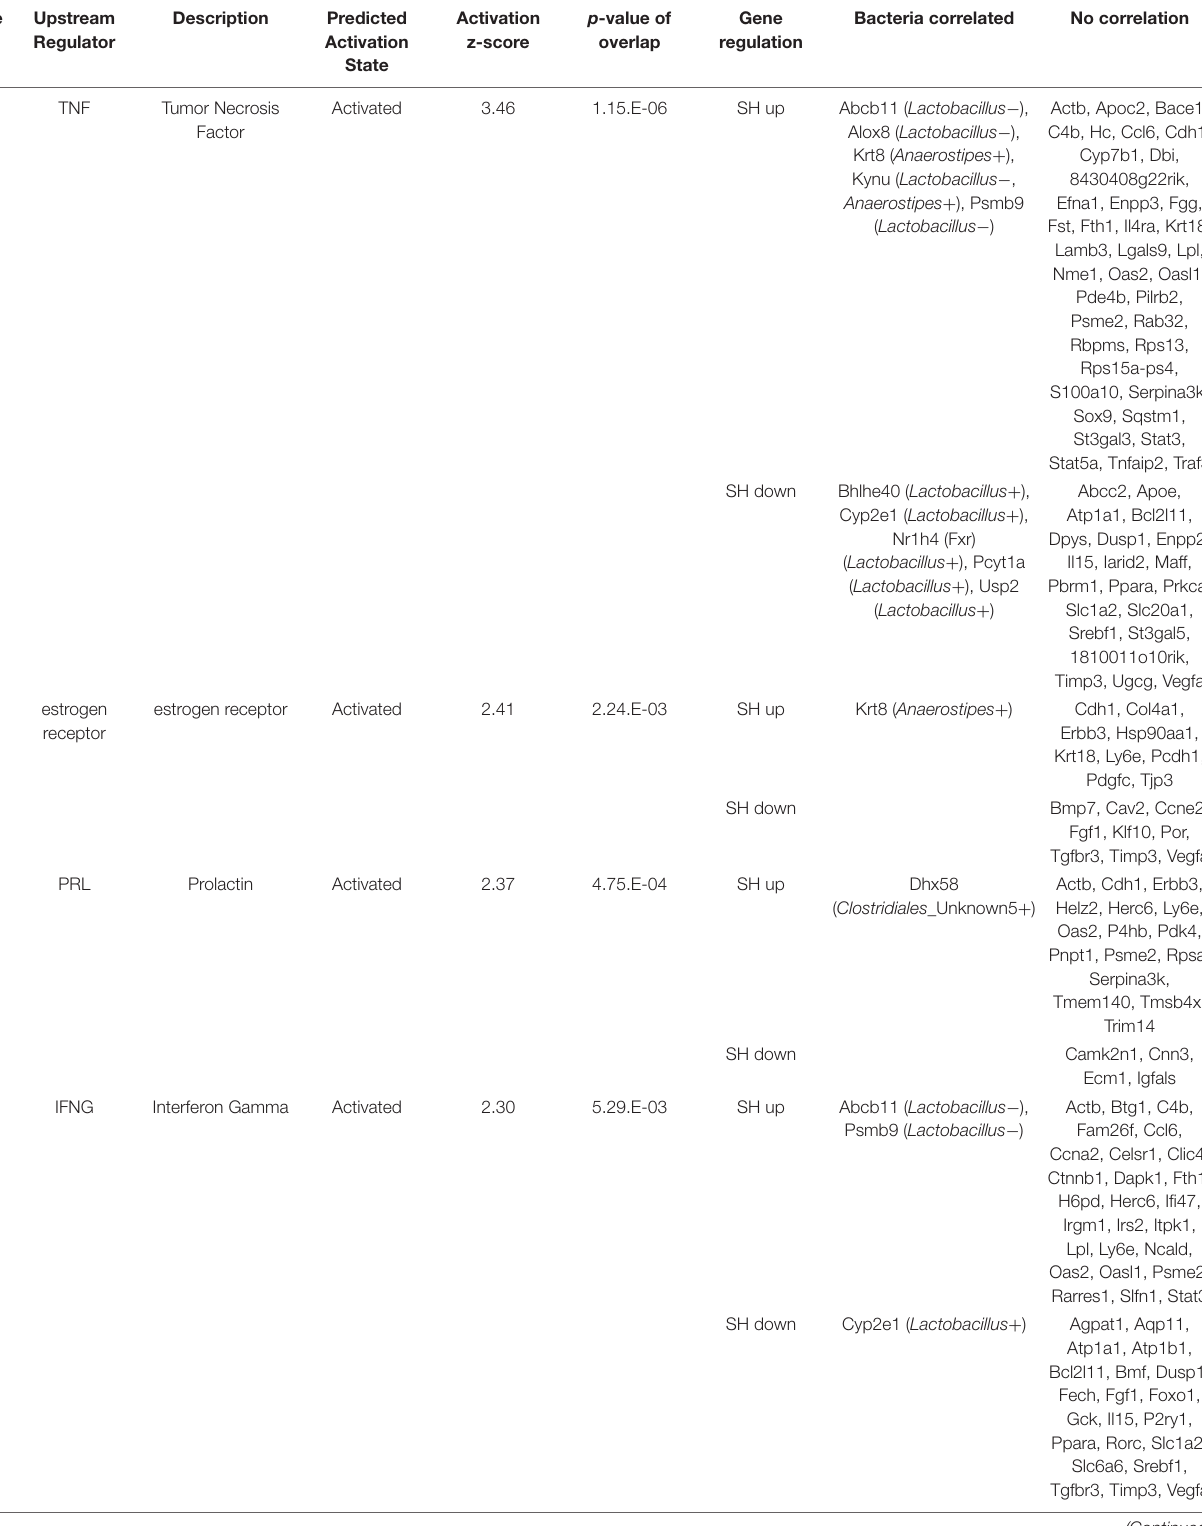
TABLE 3 | The functional enrichment analysis of the genes affected by single housing (SH) condition in the liver.